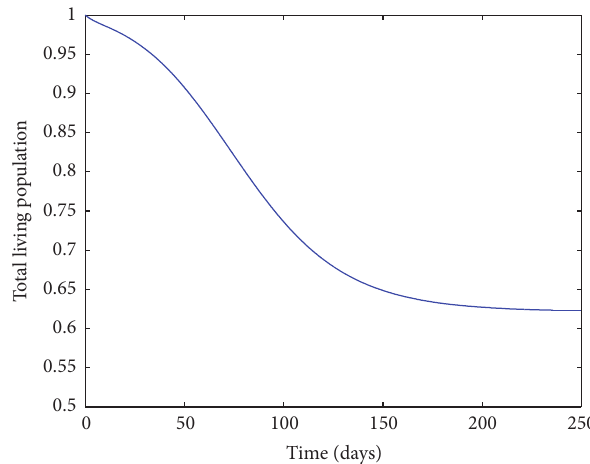
Figure 15: Evolution of the total alive population with daily culling rate of 𝜌 𝐷 = 0.1 and constant vaccination of 𝑉 = 𝑉 0 = 0.8𝑏 1 .